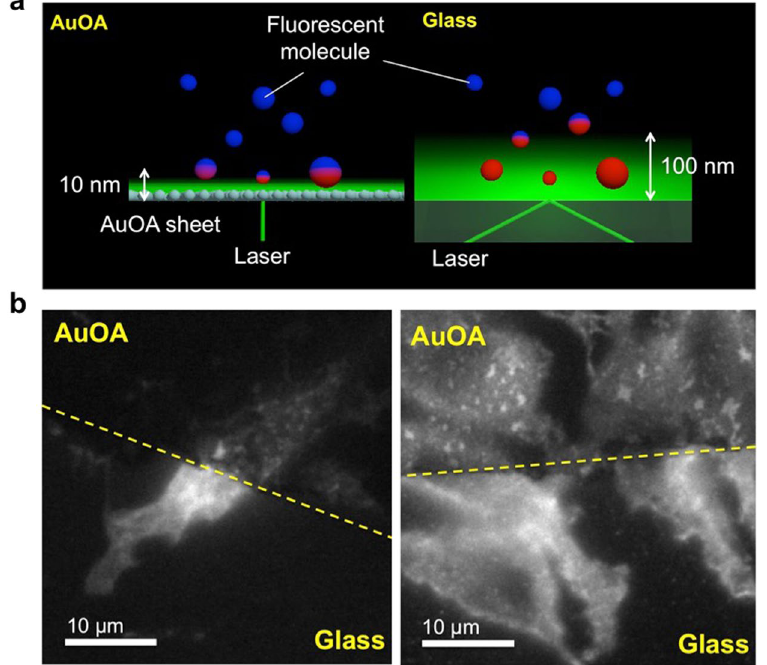
Figure 2. Comparison of interfacial fluorescence images on the AuOA sheet and on glass. ( a ) Schematic drawing of the depth of the LSPR and evanescent fields on the AuOA and glass surface, respectively. ( b) Fluorescence images of PE-labeled actin filaments in RBL-2H3 cells in aqueous media. The incubation time for the cell adhesion was overnight. The incident light was 561 nm in wavelength, and the intensity was 5 mW. The incident angle was 67° at a critical TIR angle of 61.7°. The exposure time was 30.5 msec (left) or 500 msec